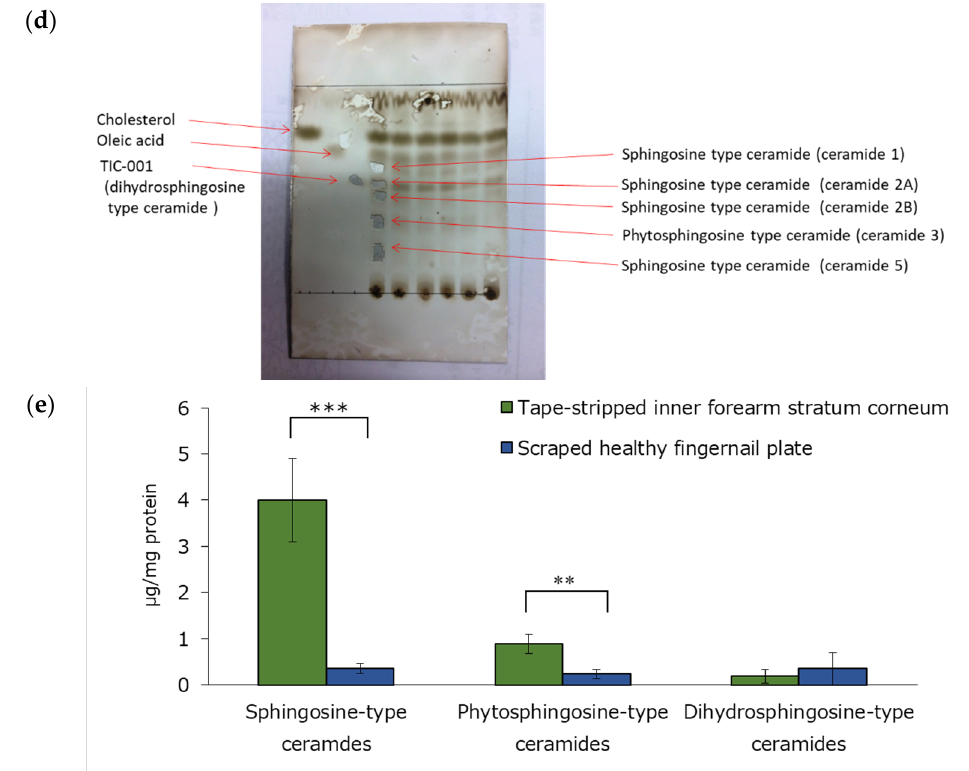
Figure 2. Fingernail images, water content, and water evaporation. ( a ): Healthy and rough fingernail images. ( b ): Fingernail water content and water evaporation of healthy and rough fingernail plates. n = 5, means ± standard deviations, **: p < 0.01. ( c ): Comparison of water content and water evaporation of fingernail plates and inner forearm skin. n = 4, means ± standard deviations, **: p < 0.01, ***: p < 0.001. ( d ): The main ceramide in the stratum corneum of the inner forearm was separated by TLC and measured by HPLC after SCDase treatment. ( e ): Comparison of ceramide types on the surface of healthy fingernail plate and inner forearm stratum corneum samples. n = 3, means ± standard deviations, **: p < 0.01, ***: p < 0.001.